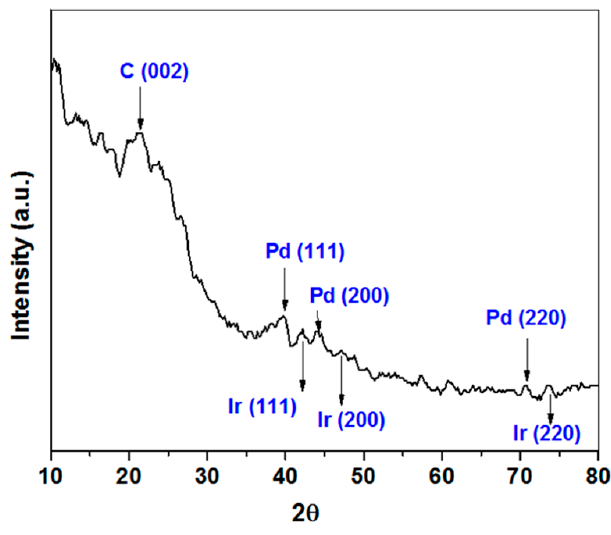
Figure 2. X-ray diffraction patterns of 1% Ir: 2% Pd/C sample.